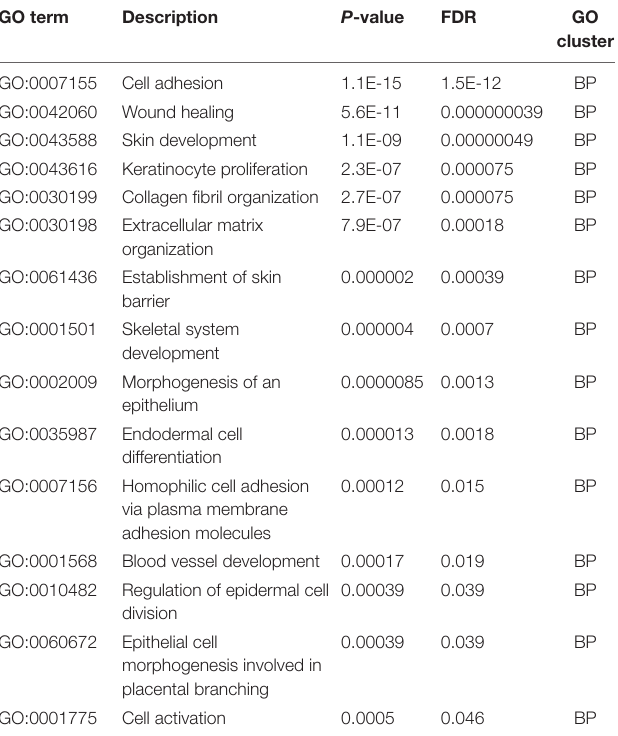
TABLE 3 | Gene ontology enrichment results, biological processes (BP).